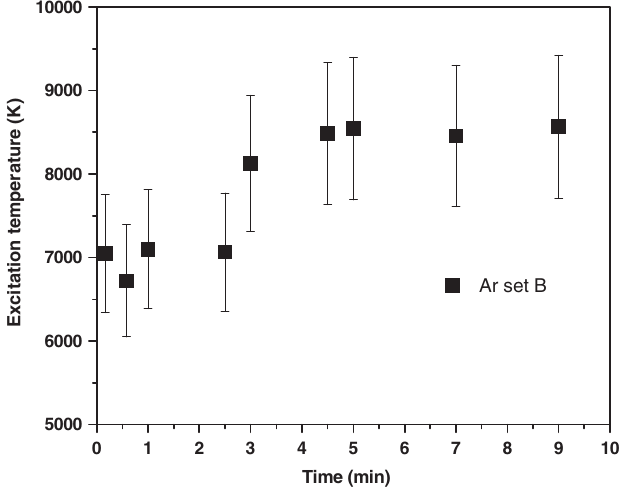
FIG. 5. Excitation temperature as a function of time. Data are taken during the etching process. Set B corresponds to Table